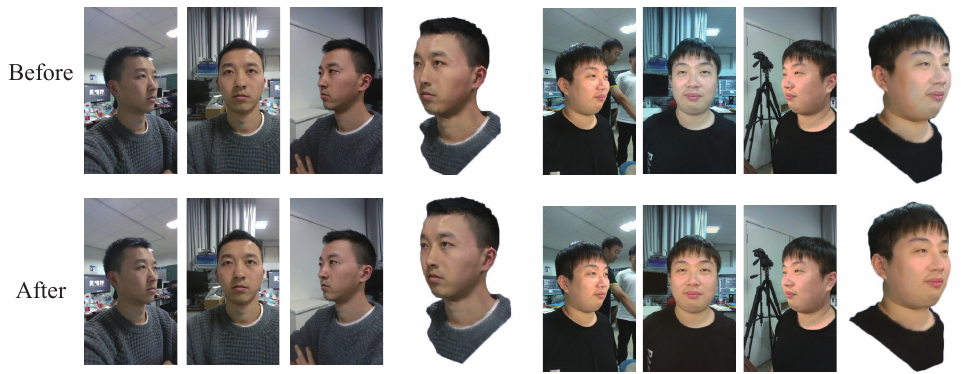
Figure 7. Multi-view texture alignment